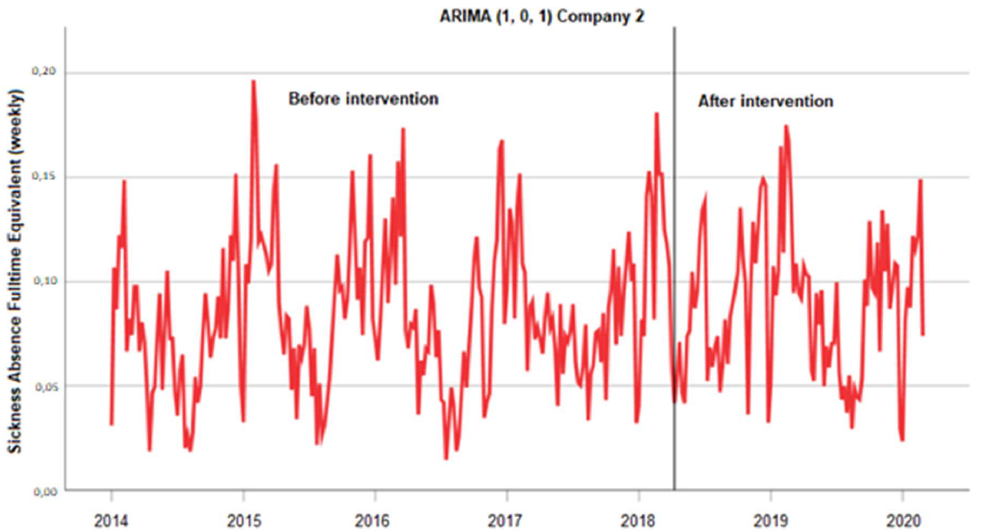
Figure 4. Absenteeism data were collected at company 2 for 321 weeks. After 221 weeks, the absenteeism policy was modified. Self-certification was prolonged from 1 day to 5 working days (=intervention). The 221-week pre-intervention was used as a baseline period to identify an ARIMA (1, 0, 1) model. The local moving average parameter was 0.086, and it was statistically significant (t = 15.638, p < 0.001). The intervention parameter 0.000 was not statistically significant (t = − 0.038, p = 0.970).